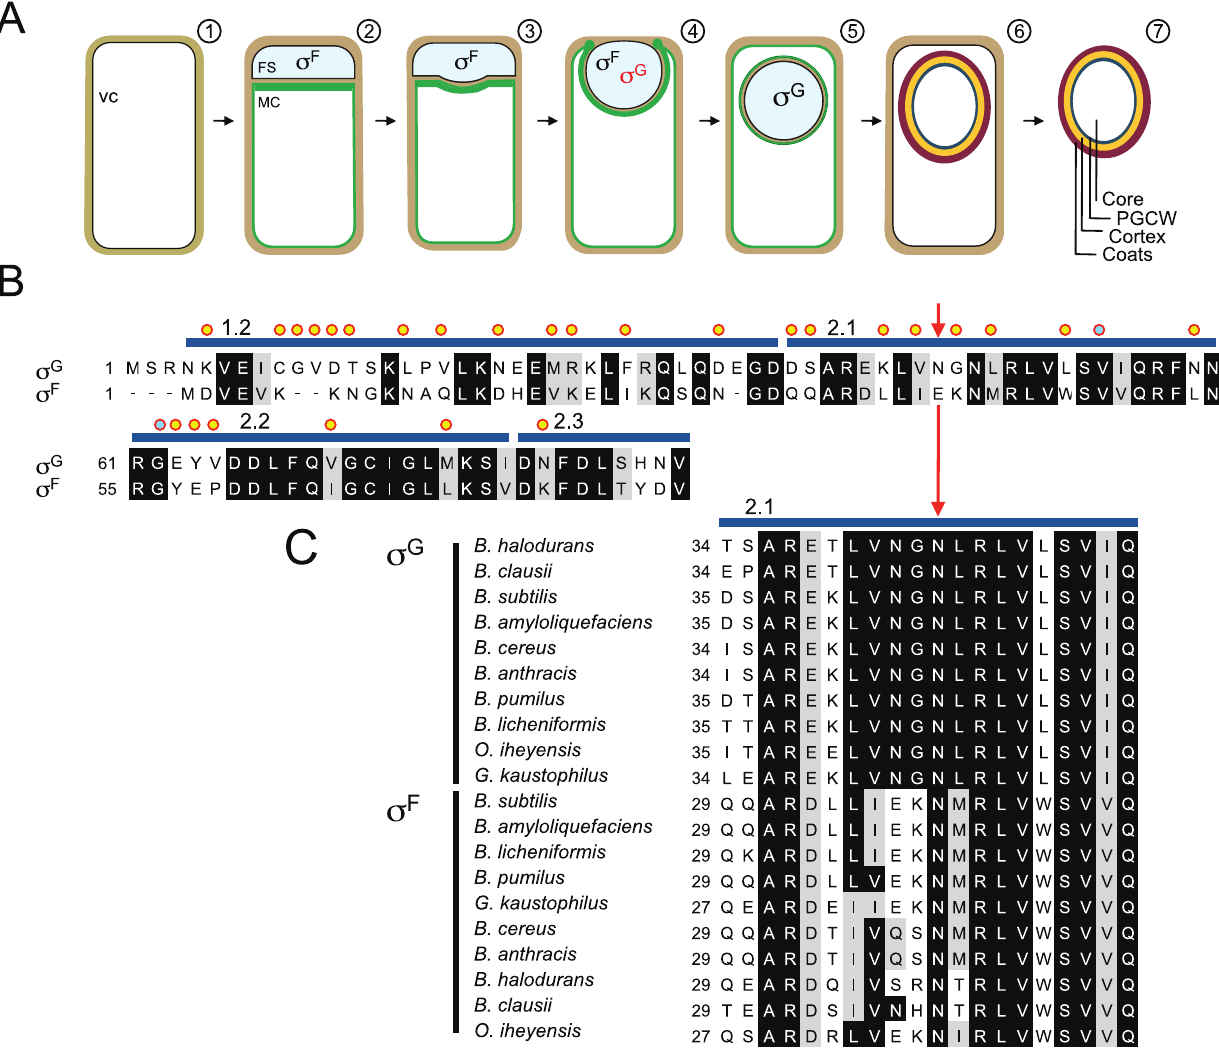
Figure 1. Segregation of s F and s G activities and mutagenesis of sigG . Panel A shows the main stages in sporulation and the temporal windows of activity of s F and s G in the forespore. Shown is (1) a pre-divisional cell, (2) a cell that has completed asymmetric division forming a forespore (FS) and a mother cell compartment (MC), (3, 4) a cell during and (5) after engulfment completion, (6) the following assembly of the spore protective layers and (7) release of the mature spore upon mother cell lysis. The mother cell membranes are colored in green. s F is activated in the forespore soon after polar division, and transcribes the sigG gene, but s G only becomes active following engulfment completion. Red and black denote inactive and active s G , respectively. Panel B shows an alignment between the N-terminal regions of s G and s F from B. subtilis . Residues in s G that were subject to mutagenesis are indicated by yellow circles or, for N45, by a red arrow. The blue lines above the sequence delimit conserved regions 1.2 through 2.3. Residues previously implicated in binding of SpoIIAB to s F are marked with a blue circle. Panel C shows the alignment of region 2.1 of B. subtilis s G (highlighting residue N45 with a red arrow) with the same region of s G and s F from other, selected, Bacillus species. The alignments (B and C) were prepared using ClustalW (http://www.ch.embnet.org/software/ClustalW.html). Black and grey backgrounds highlight identical or conserved residues, respectively.